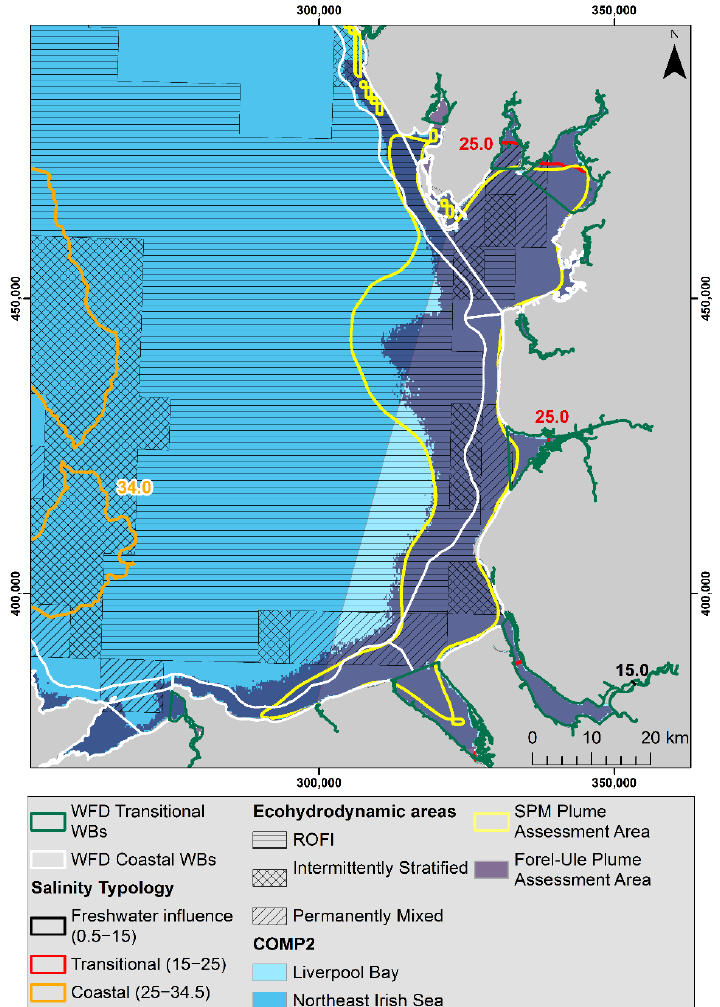
Figure 12. Traditional water quality assessment typologies in Liverpool Bay, compared to the newly defined Forel–Ule